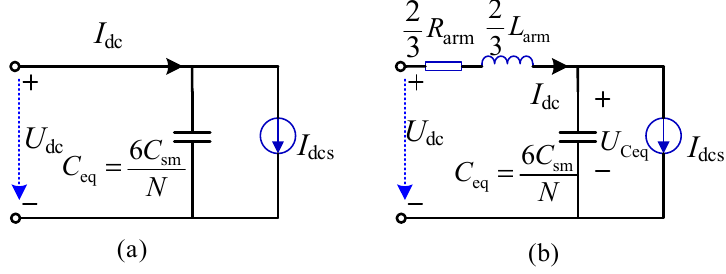
Figure 5. DC-side model of the MMC. ( a ) Conventional first-order model; ( b ) Improved second-order model.